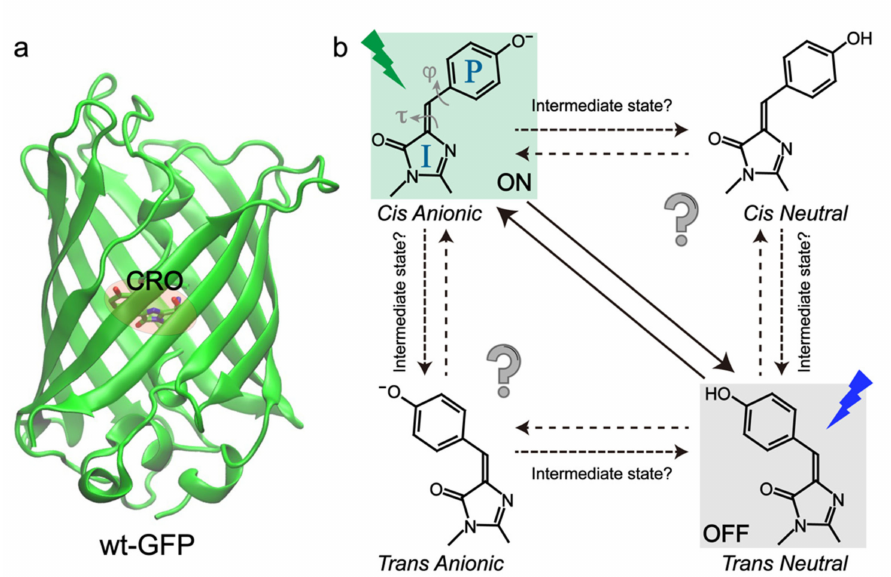
Figure 1. Schematic of the overall structure and photoswitching mechanisms of RSFPs. ( a ) Crystal structure of the wild-type green fluorescent protein (wtGFP) (PDB ID: 1EMA) [25]. ( b ) The photoin- duced structural and protonation state changes of the chromophore (P- and I-rings denoted in the “ON” state) during reversible switching. Possible transitions and associated intermediate states are indicated by a network of solid and dashed